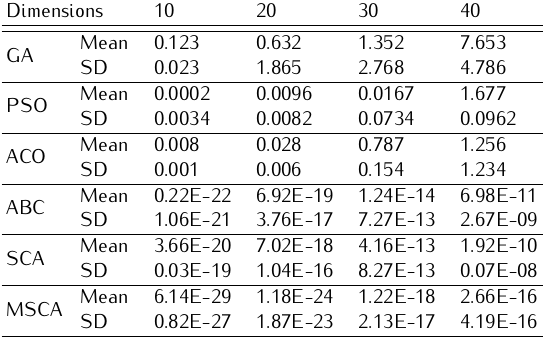
Table A.5. The results of GA, PSO, ACO, ABC, SCA and MSCA for Weierstrass function.